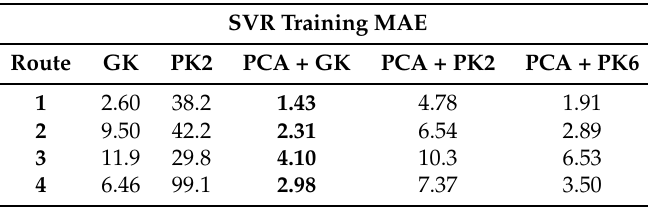
Table 3. Mean absolute error (MAE) of SVR training for GK, PK2, PCA + GK, PCA + PK2 and PCA + PK6 models.